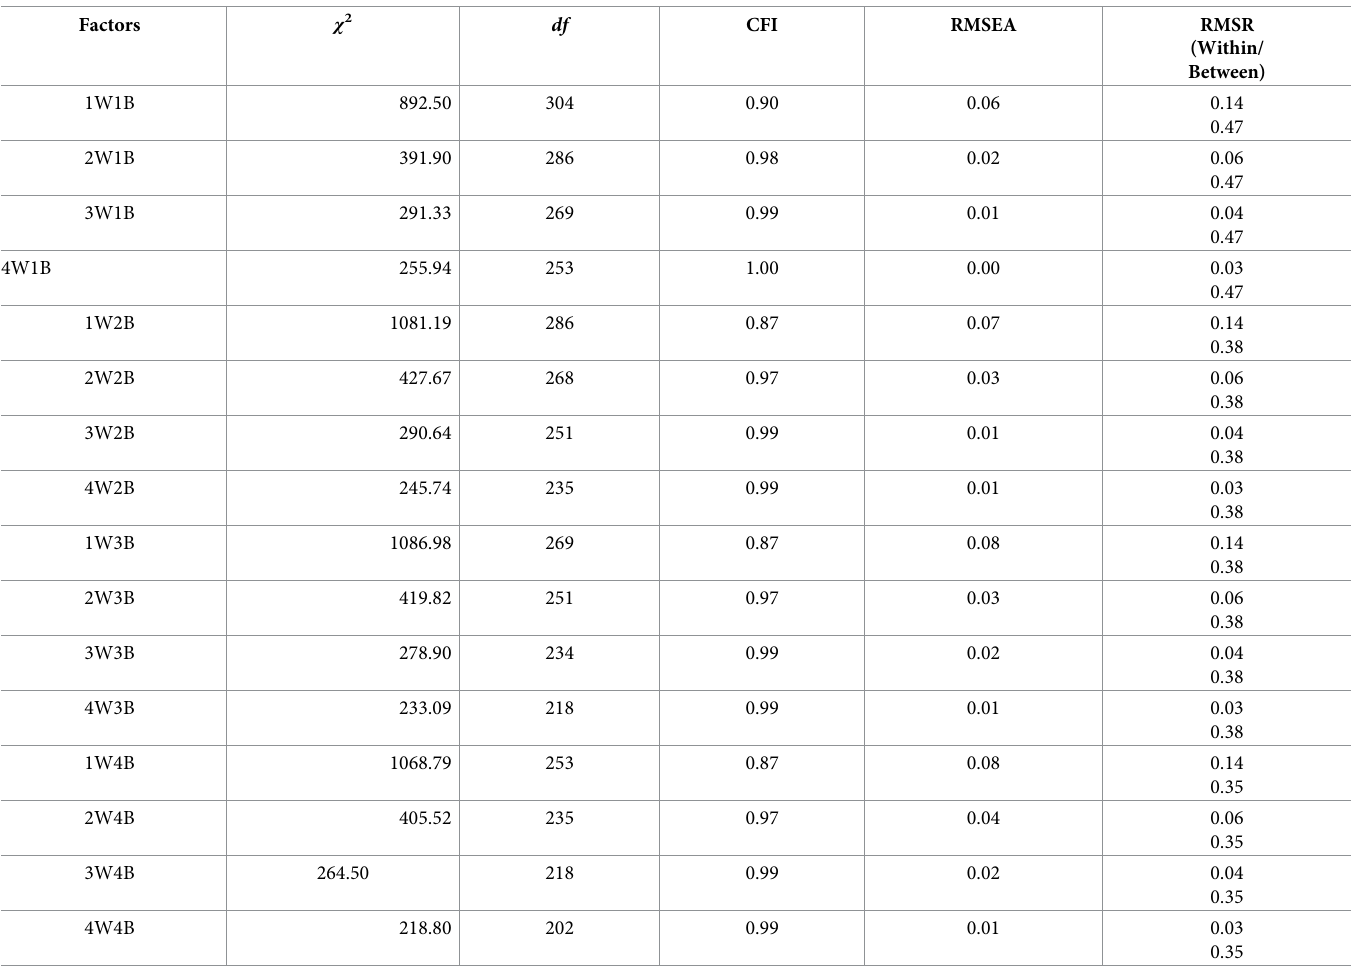
Table 3. Multilevel exploratory factor analysis for 19 items at Time